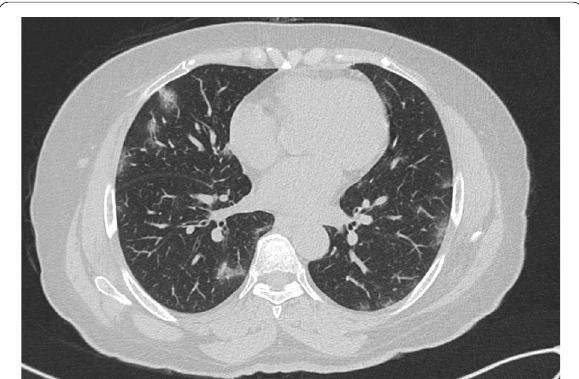
Fig. 1 Axial HRCT thorax image showing ground-glass opacities in subpleural and peripheral regions of bilateral lungs typical for COVID pneumonitis